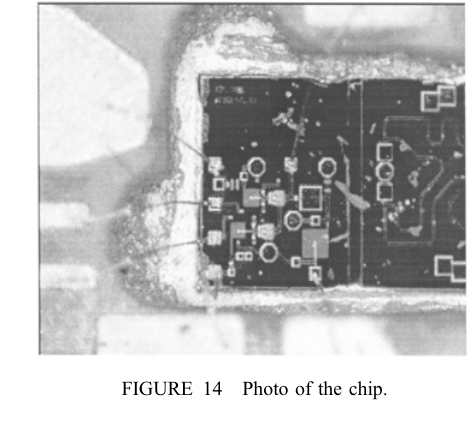
FIGURE 14 Photo of the chip.